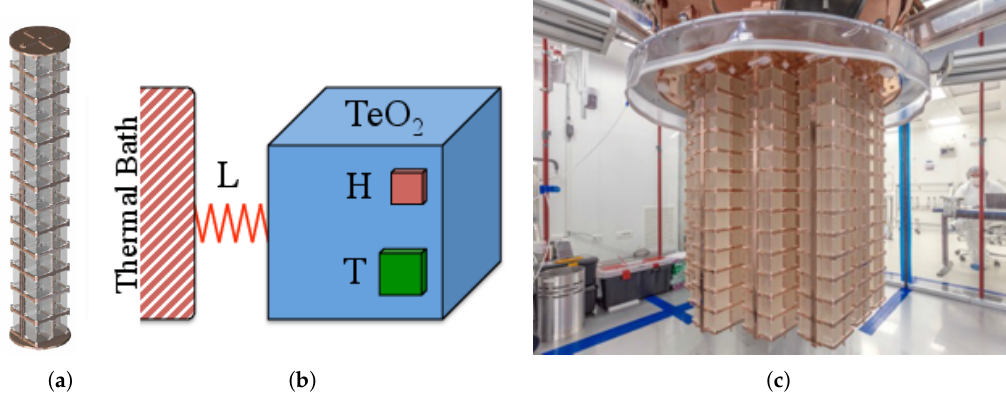
Figure 1. ( a ) Schematic of a single Cryogenic Underground Observatory for Rare Events (CUORE) tower, with 13 floors of four crystals. Each tower has 52 crystals for a total mass of ∼ 39kg of TeO 2 or ∼ 10.8kg of 130 Te. The CUORE detector is composed of 19 such towers. ( b ) A schematic of a CUORE bolometer. The TeO 2 crystal acts as the absorber, and is connected to a heat bath through a weak thermal link, L . Each bolometer is instrumented with an NTD thermistor, N , and a heater to inject heat pulses, H . ( c ) The CUORE detector assembled and installed in the CUORE cryostat, inside the CUORE cleanroom. Picture from